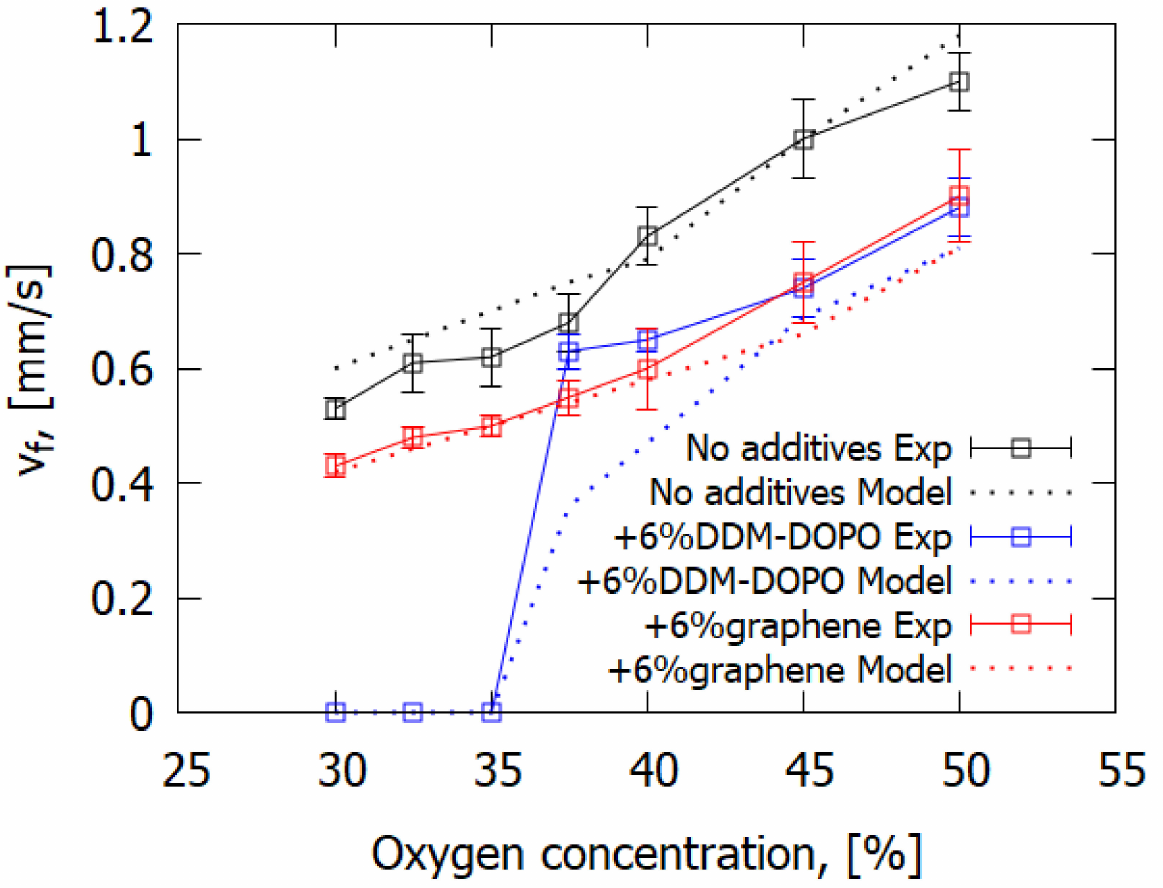
Figure 4. The measured and calculated dependences of ROS on oxygen concentration for downward flame spread over